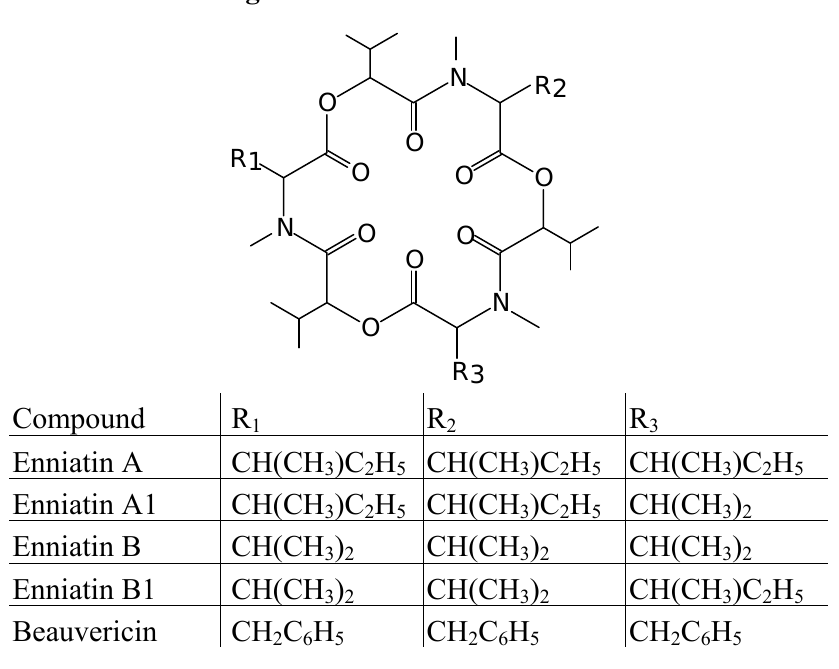
Figure 3. Structures of enniatins.